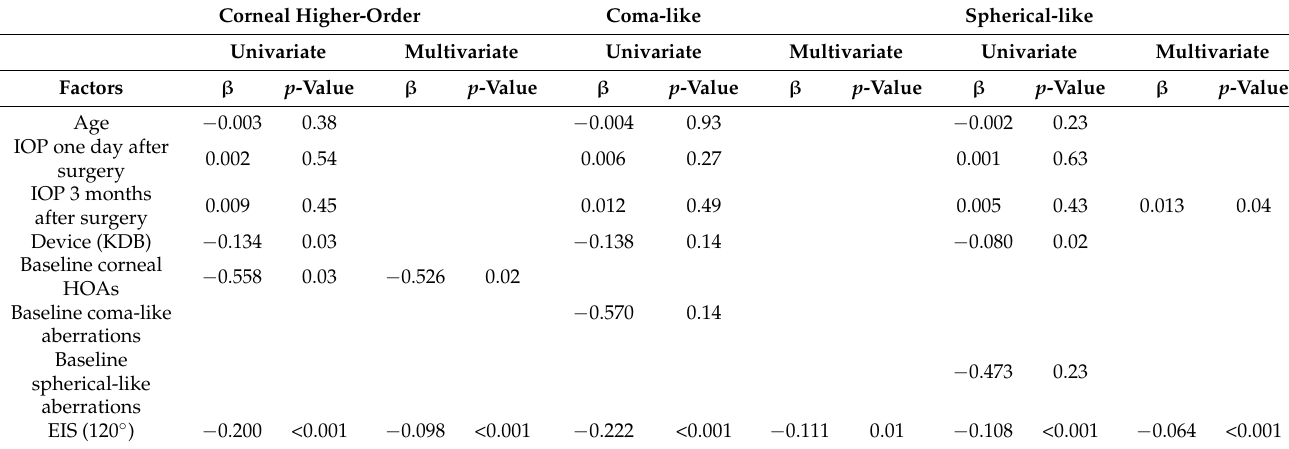
Table 4. Stepwise multiple regression analysis for factors associated with postoperative corneal higher-order, coma-like, and spherical-like aberrations’ changes.